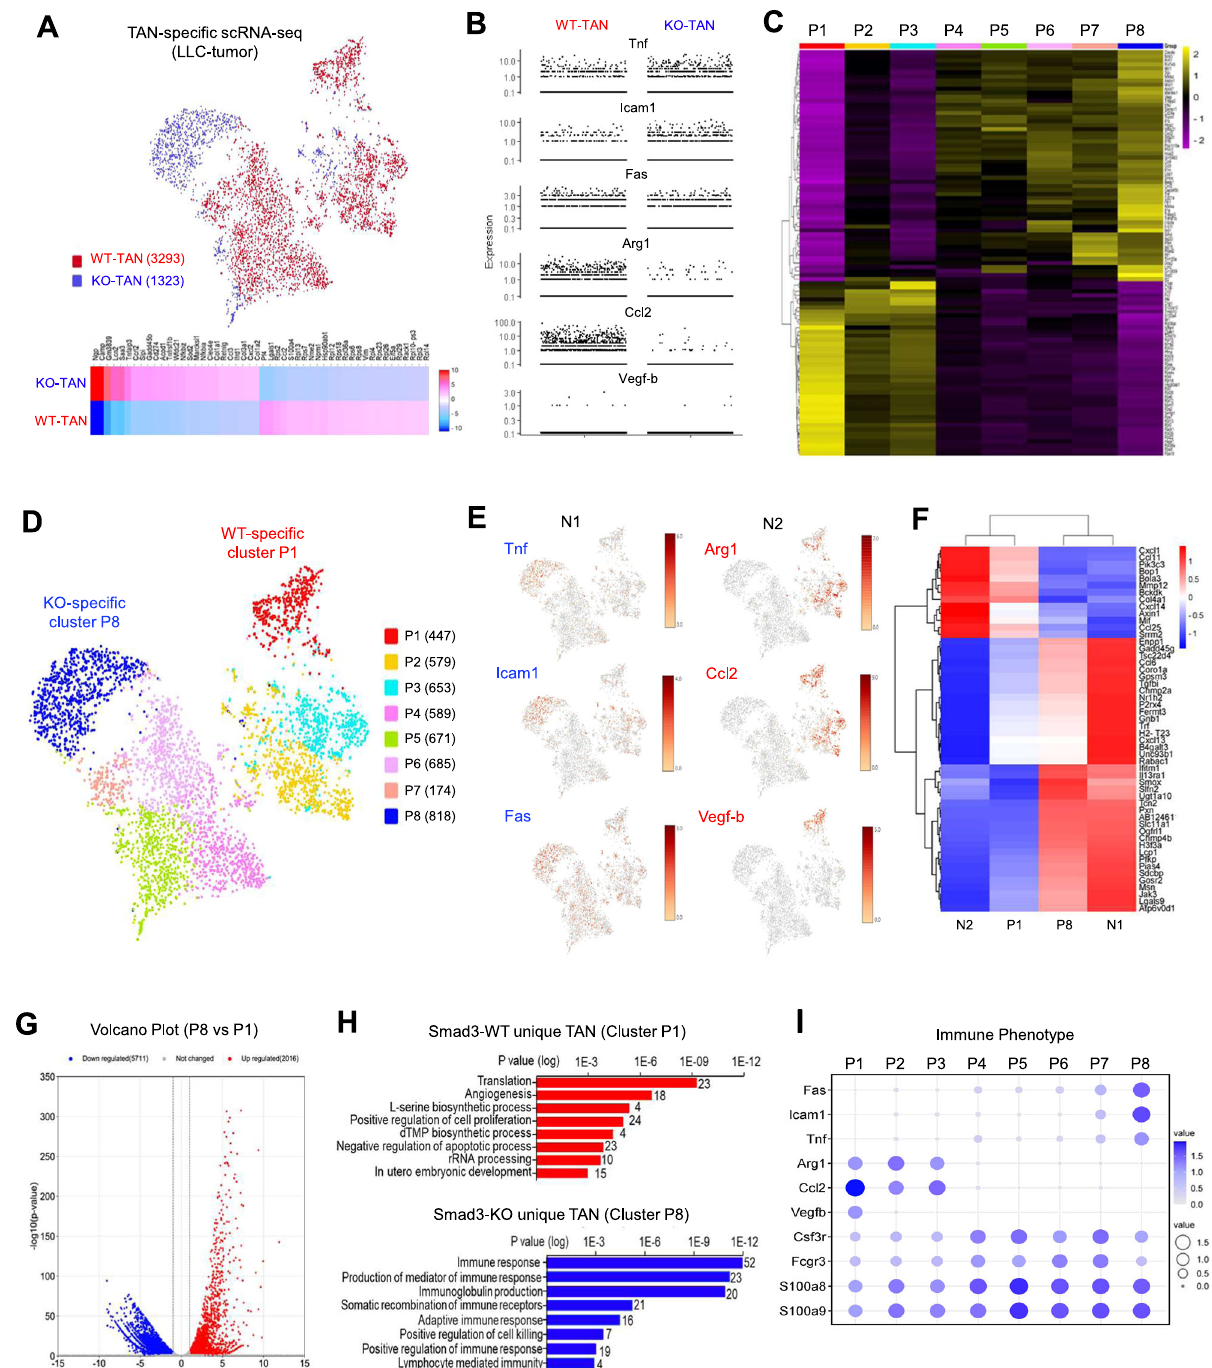
Fig. 3 | Transcriptome analysis showing that Smad3 regulates N1/N2 polar- ization in TANs. TANs (Ly6G + CD11b + cells) sorted from LLC tumors in Smad3-WT and Smad3-KO mice (pooled from eight tumors /group) underwent scRNA-seq. A t-SNE plot and heatmap of the fi ltered scRNA-seq dataset show distinct tran- scriptome pro fi les of TANs from Smad3-WT (red) and Smad3-KO (blue) mice. B ExpressionplotshowsSmad3-KOTANspredominantlyexpressmarkersofanN1 phenotype(Tnf,Icam1,andFas),whereasSmad3-WTTANspredominantlyexpress markersof anN2 phenotype(Arg1, Ccl2, and Vegf-b). C Heatmap and D t-SNE plot showing the top 100 differential expressed genes (DEGs) and the relationship amongst eight clusters (P1 toP8) of Smad3-WT and -KO TANs unbiasedlygrouped using the Louvain method. E t-SNE plots show enrichment of N2 markers (Arg1, Ccl2, and Vegf-b) in the Smad3-WT-speci fi c P1 cluster and enrichment of N1